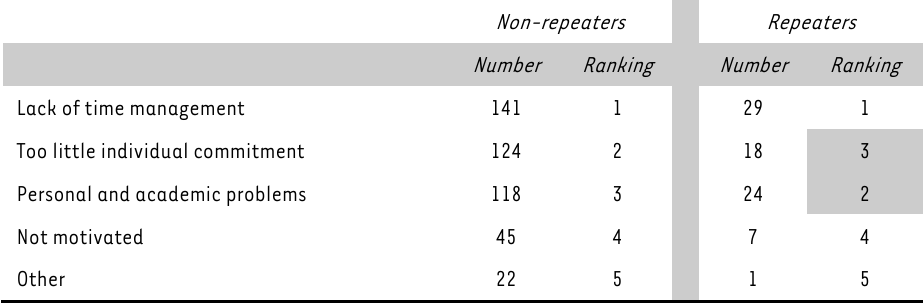
TABLE 9: Factors hindering own success split between repeaters and non-repeaters Non-repeaters Repeaters Number Ranking Number